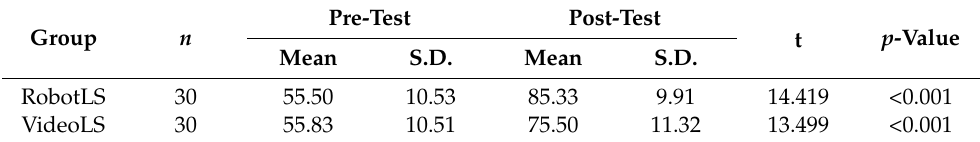
Table 2. Paired sample t-test of pre- and post-test regarding health